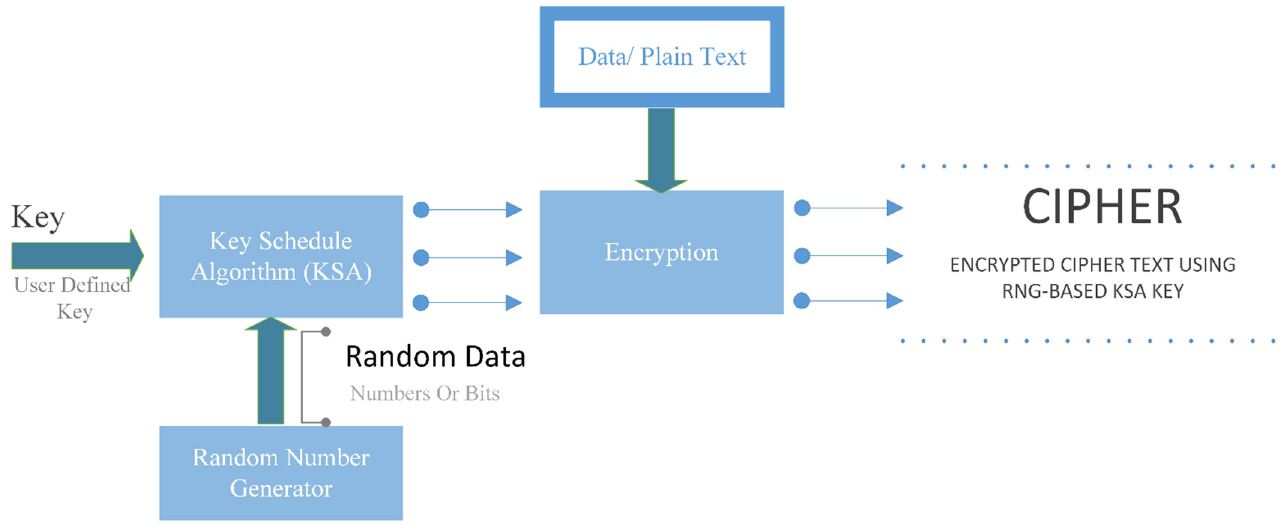
Figure 2. Key Schedule Algorithm (KSA) and encryption of an RNG ‐ based cryptosystem. RNGs’ randomness critically depends on the type of RNG.